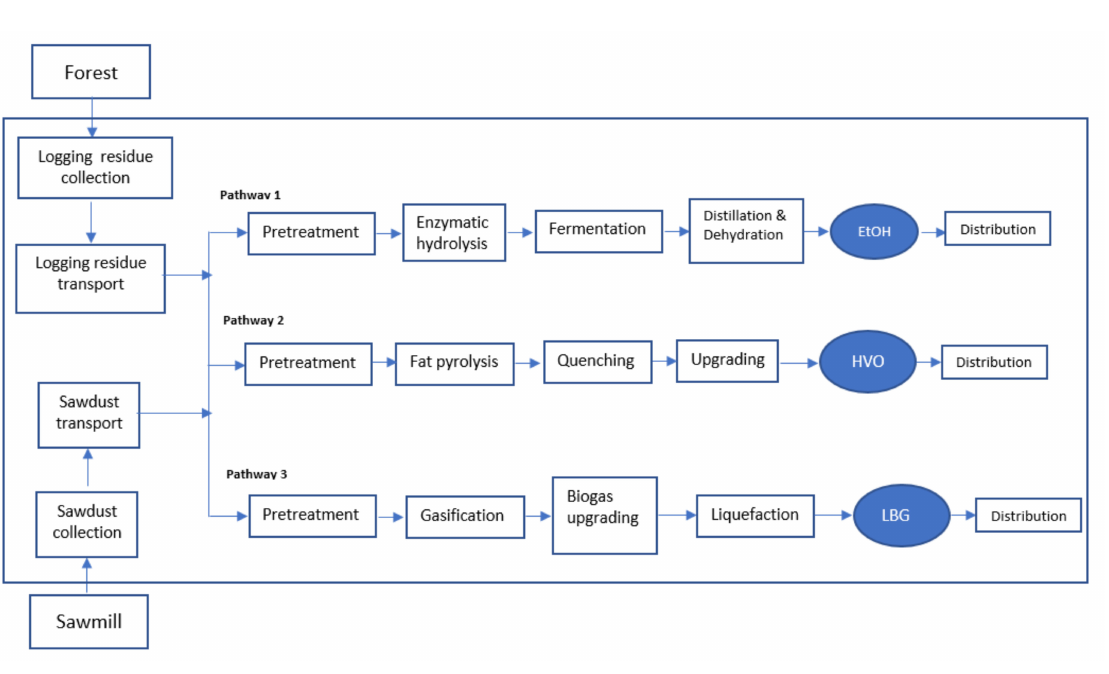
Figure 1. System boundary used in the case